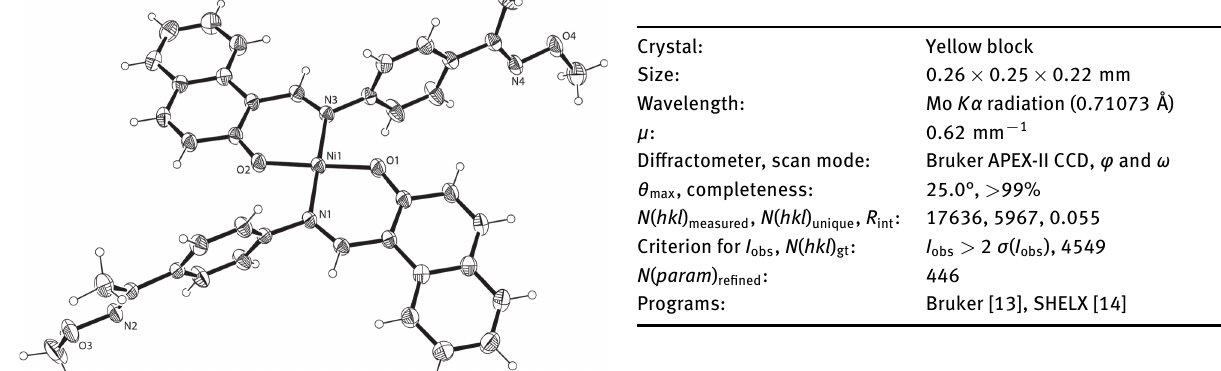
Table 1: Data collection and handling.